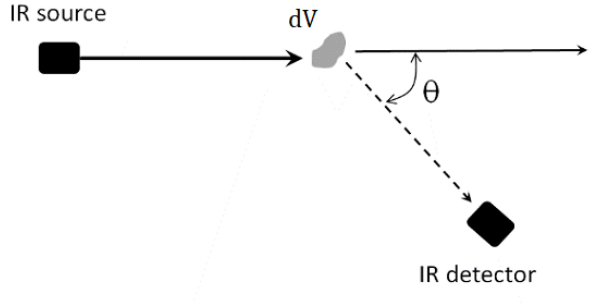
Figure 1. A scheme showing the scattering process.